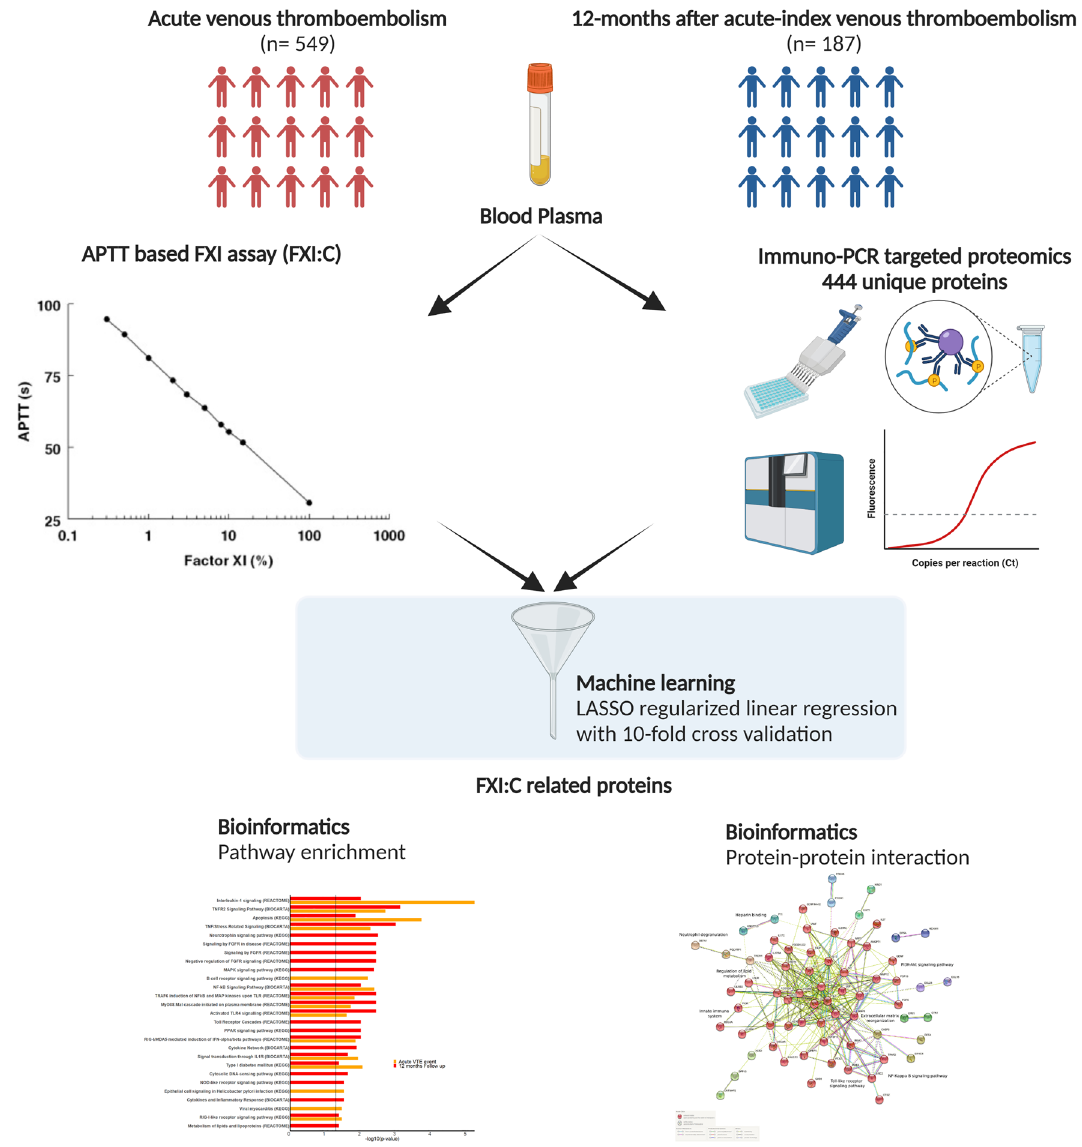
Figure 6. Methods overview and flow chart of the study investigating FXI:C related